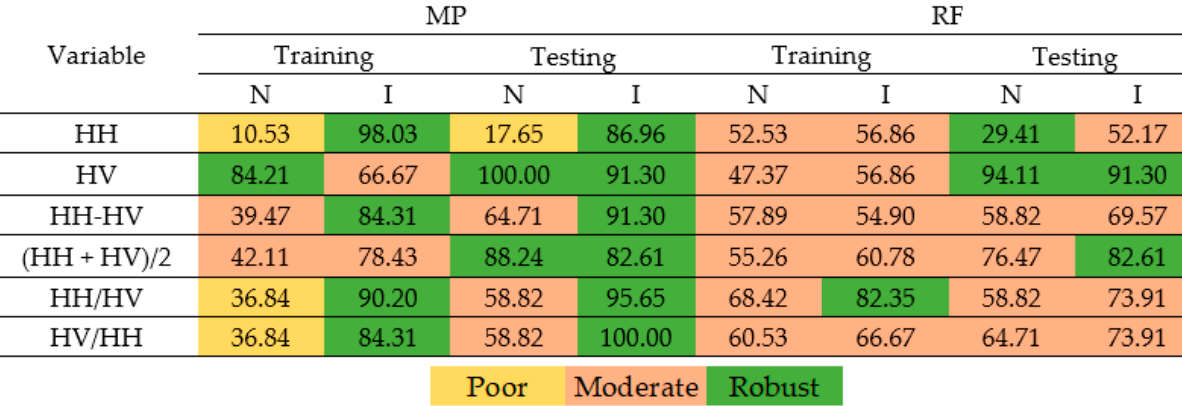
Figure 4. The success rate (%) of non-infected (N) and infected (I) by G. boninense for variables of backscatter used.